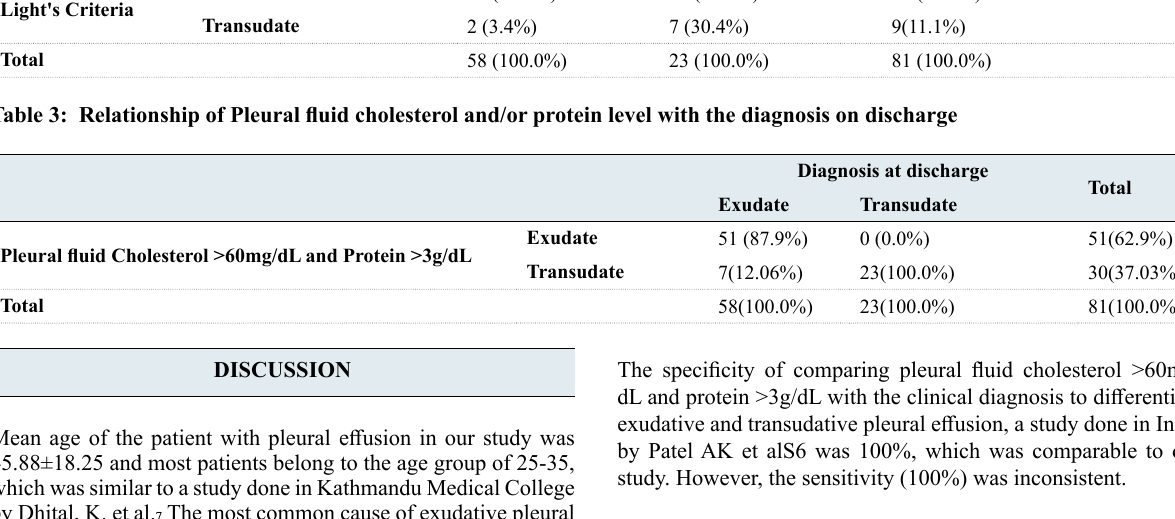
Diagnosis at discharge Total Exudate Transudate